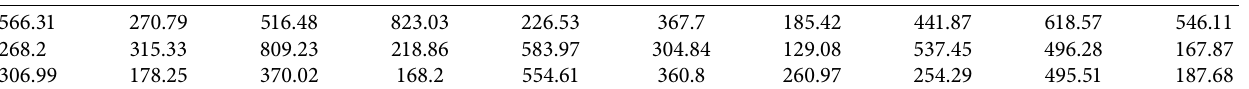
Table 6: Data set 1 (5mm) MPa.